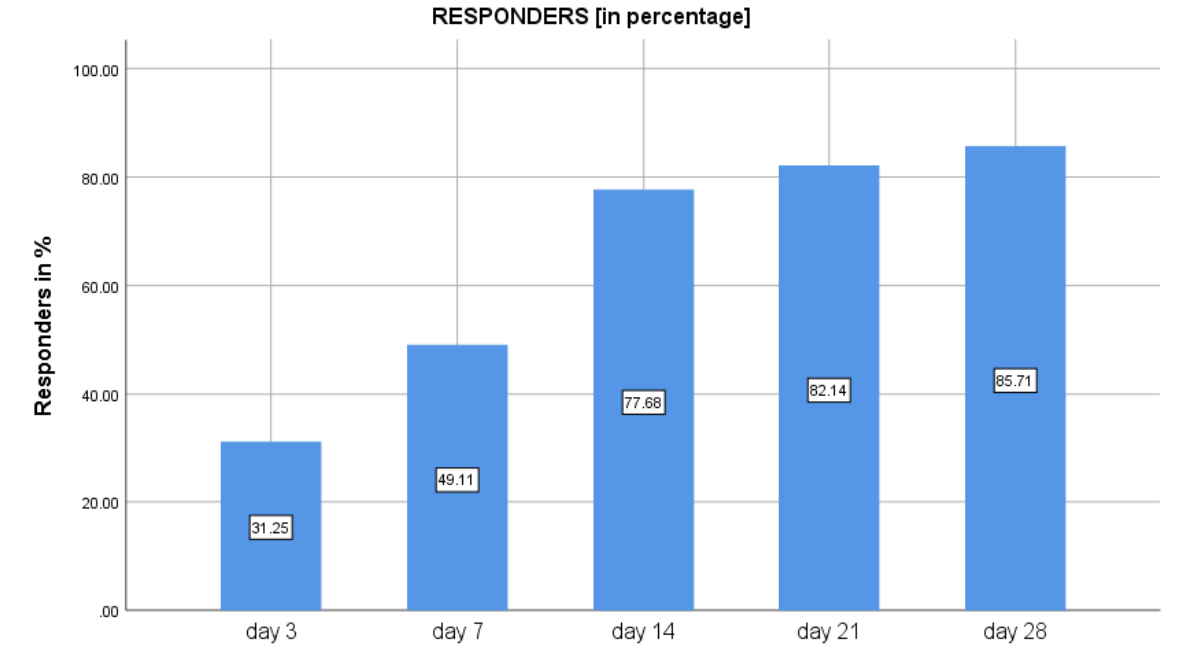
5 Table 1. Analysis of reduction in crying time, n = 112. Days Crying Time Reduction in Mins Percentage Reduction 95% Confidence Interval − 1 to 3